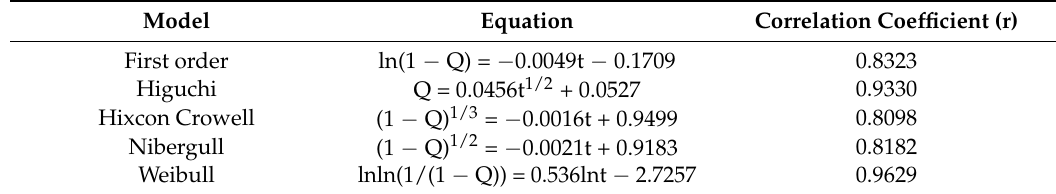
Figure 6. Release profile detected for α - TOC in the reservoir for dialysis bags containing α -TOC- NaOl/RebA nanocomplex dispersions and free α -TOC in PBS medium containing 20% ethanol and 0.5% Tween 80. The inset figure shows release kinetics in the first 10 h. Error bars are standard deviations ( n = 3). Table 1. Release equations of Table 1. Release equations of nanoemulsion.